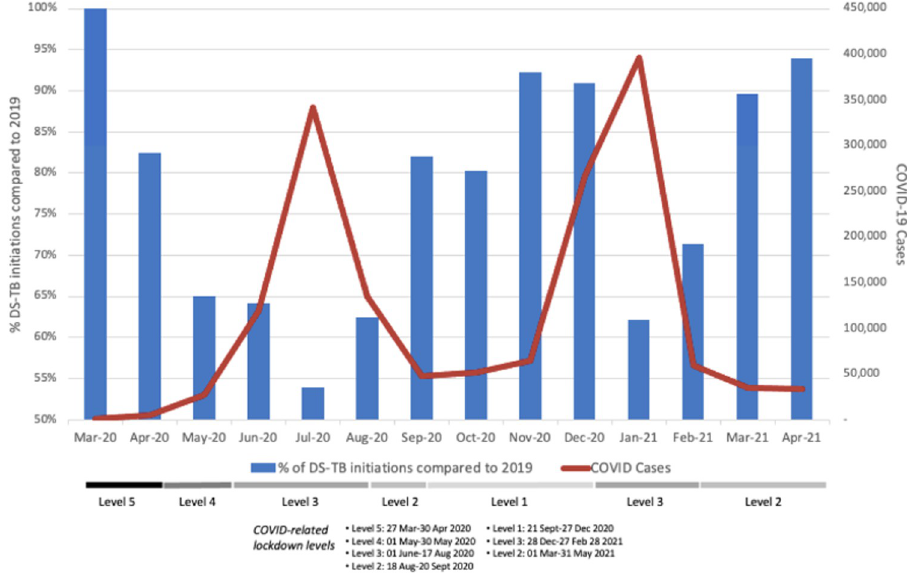
Fig 5. Proportion TB treatment initiations compared to the same month in 2019 and new COVID-19 cases per month, March 2020-April